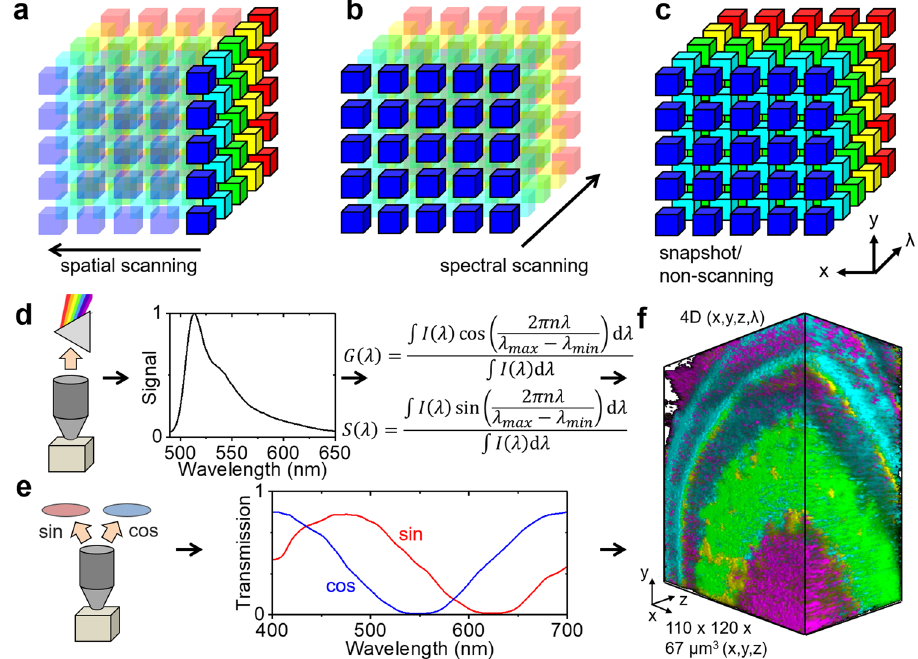
Fig. 1 Concept and advantages of phasor-based hyperspectral snapshot microscopy. a , b Conventional hyperspectral imaging methods rely on slow spatial or spectral scanning. c Faster snapshot methods exist but often compromise spatial and/or spectral resolution and can be computationally demanding. d In conventional phasor-based hyperspectral imaging, an emission spectrum is acquired in each pixel/voxel that is then computationally transformed to the spectral phasor plot for analysis by a sine/cosine transformation. e Instead, the sine/cosine fi lter approach to hyperspectral imaging directly transforms the fl uorescence emission to spectral phasor coordinates in hardware, no spectral detector and image data post-processing are required. f The resulting substantial improvement in image acquisition and data processing speed allows the generation of 4D data ( x , y , z , λ ) in seconds taking full advantage of the high light throughput and minimal photobleaching of light sheet